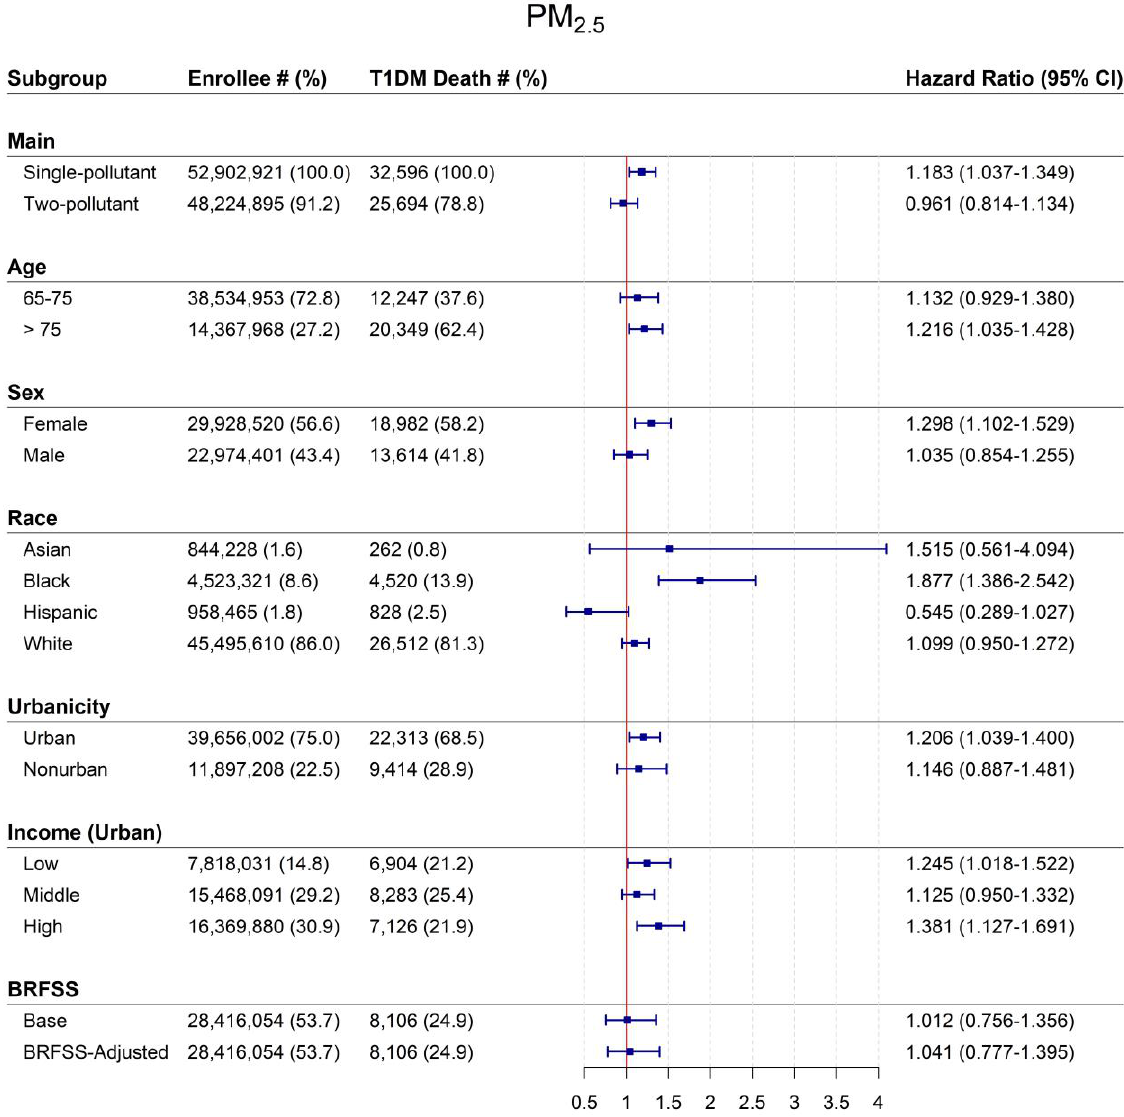
Estimated using Cox PH models with strata for age (1-year age categories, with 90+ years old as one